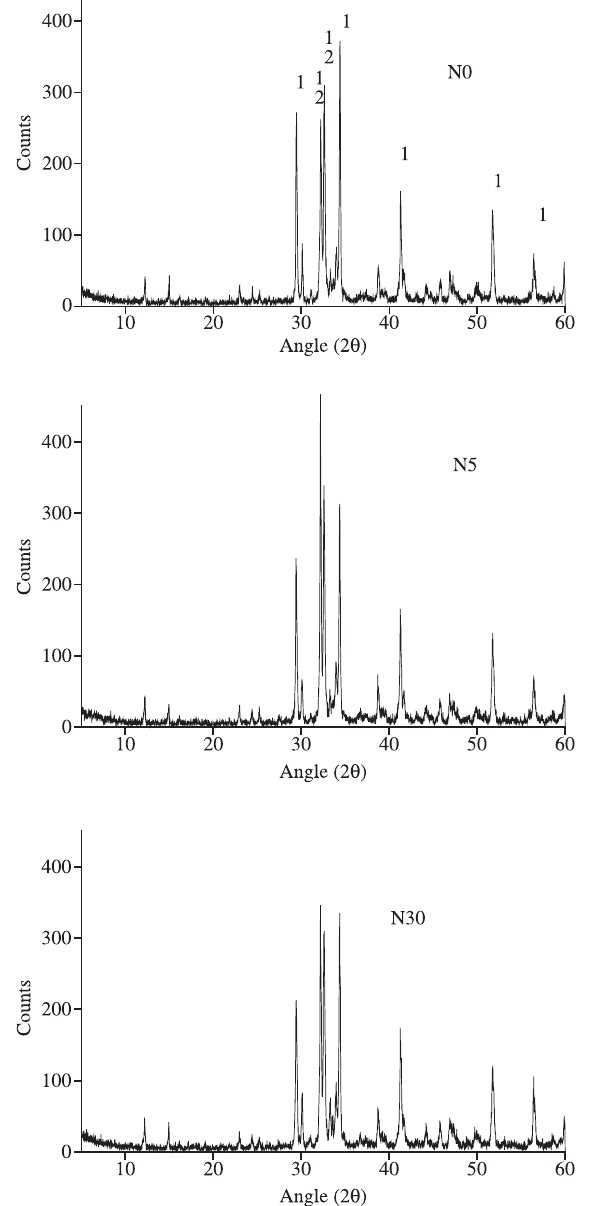
Table 4. Location of the C